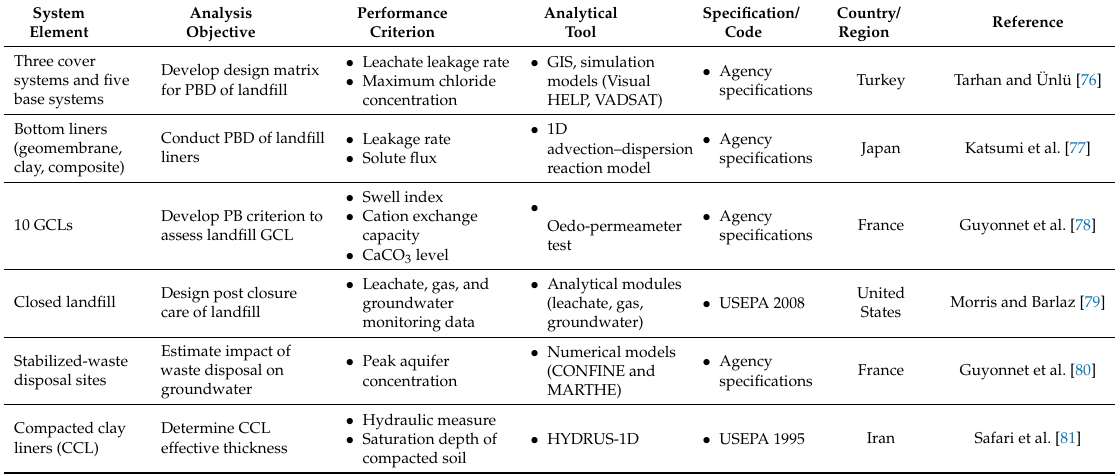
Table A5. Characteristics of landfill design applications.